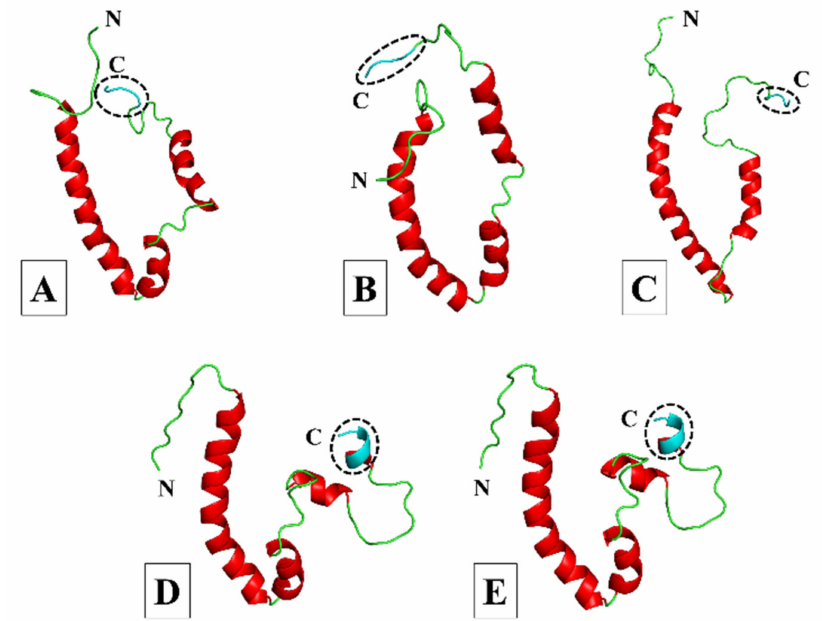
Figure 3. Cartoon representation of the three-dimensional (3D) models of the SARS-CoV-1, -2, MERS-CoV, HCoV-229E, and HCoV-NL63 envelope (E) proteins. ( A ) SARS-CoV-1. ( B ) SARS-CoV-2. ( C ) MERS-CoV. ( D ) HCoV-229E. ( E ) HCoV-NL63. Models were generated using MODELLER software and based on the partially resolved nuclear magnetic resonance (NMR) structures for SARS-CoV-1 E (PDB IDs: 5X29 and 2MM4) obtained from the Research Collaboratory for Structural Bioinformatics (RCSB) protein data bank (PDB) [49–52]. The models for SARS-CoV-1, -2 and HCoV-229E were generated from the 5X29 template, the MERS-CoV model was constructed from the 2MM4 template, and the HCoV-NL63 model was generated using the HCoV-229E E protein model as the template. The amino (N) and carboxy (C)-termini are indicated accordingly; coils are shown in green, α -helices in red, and the C-terminal PDZ-binding motif (PBM) in cyan and enclosed by a circle of dashed